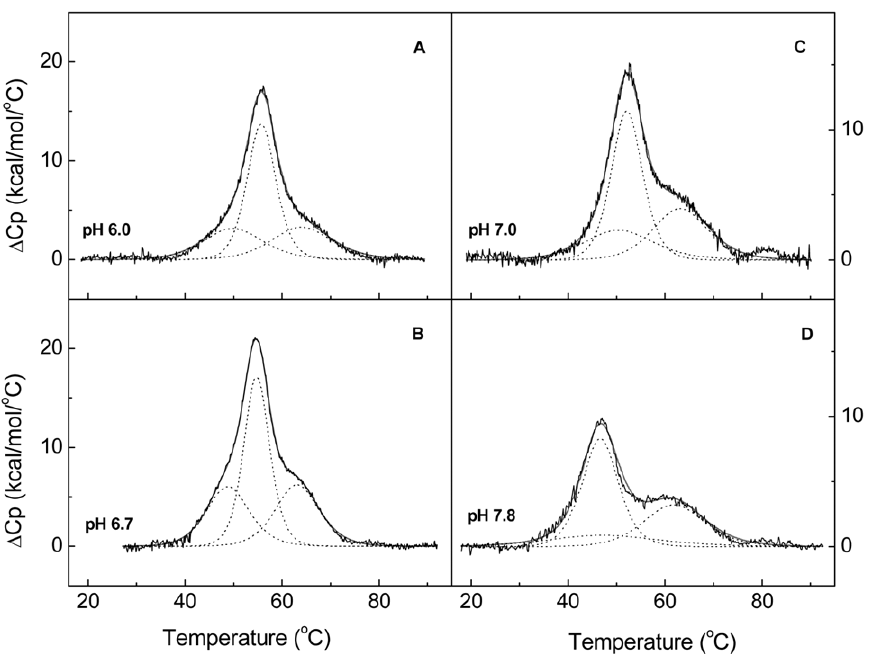
Figure 5. Influence of pH on Cpl-7 DSC denaturation profiles. Panels ( A ) to ( D ) show the thermograms registered at 20 u C h 2 1 in 20 mM Pi buffer at the pH values indicated in the curve labels. Dotted lines depict the results of endotherm deconvolution in independent two-state transitions (Table 3) and grey traces are the theoretical envelopes.